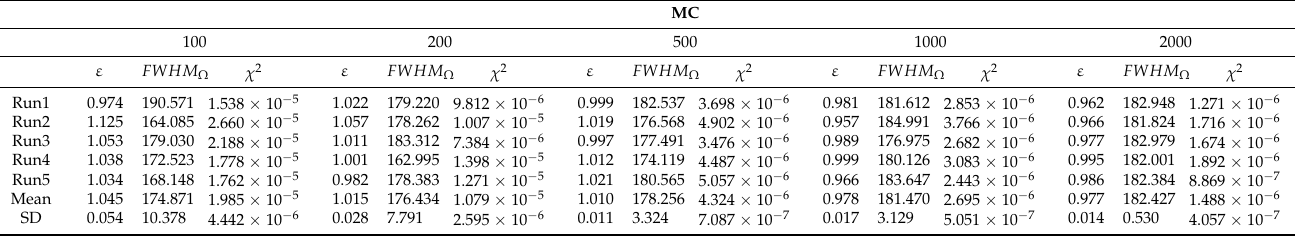
Table A3. Dependence of the quality of the DE fitting on MC (two free parameters). Results of the PSIIRC linear spectroscopy fitting obtained after 5 runs of DE are shown for five different MC values. The target function is the artificially created experimental data with MC =